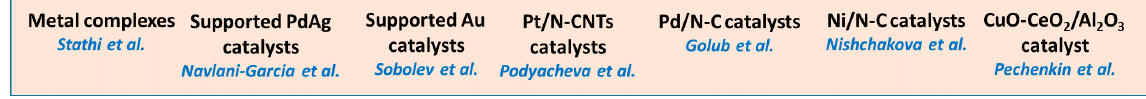
Figure 1. Catalysts for hydrogen production from formic acid decomposition considered in the Special Issue.